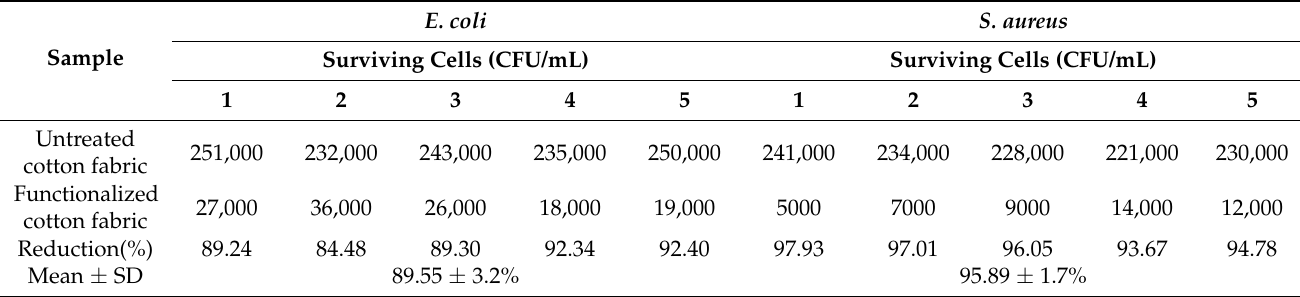
Table 3. Antibacterial characteristic of cotton fabrics against S. aureus and E. coli